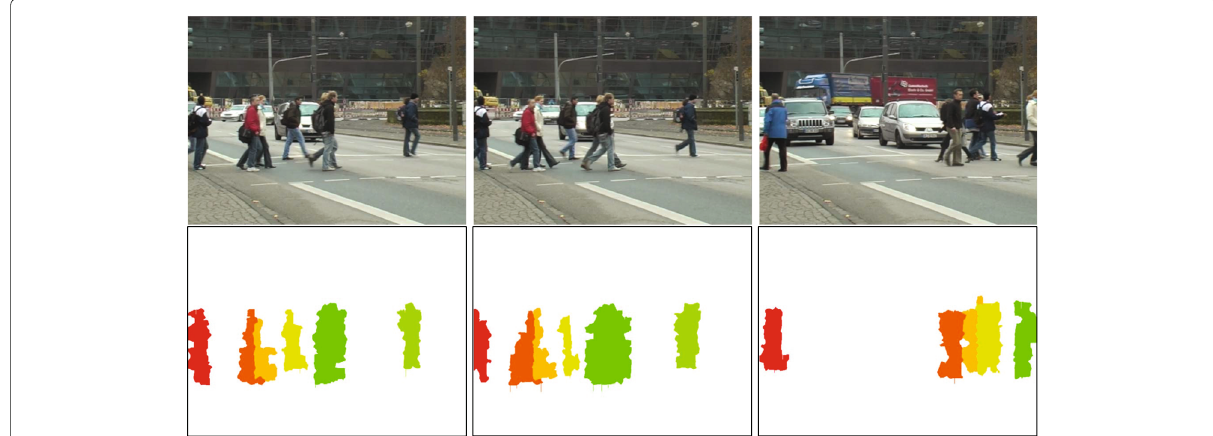
Fig. 10 Examples of object labeling result on TUD dataset. Different colors indicate different instances. Other categories are visualized as